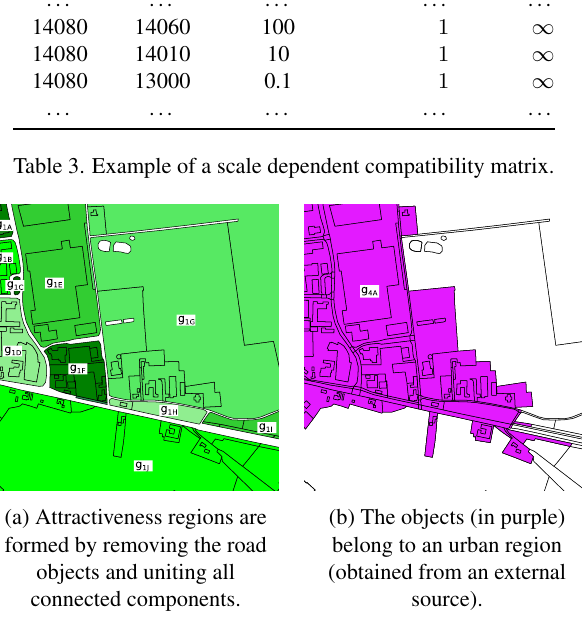
Figure 2. Examples of attractiveness regions